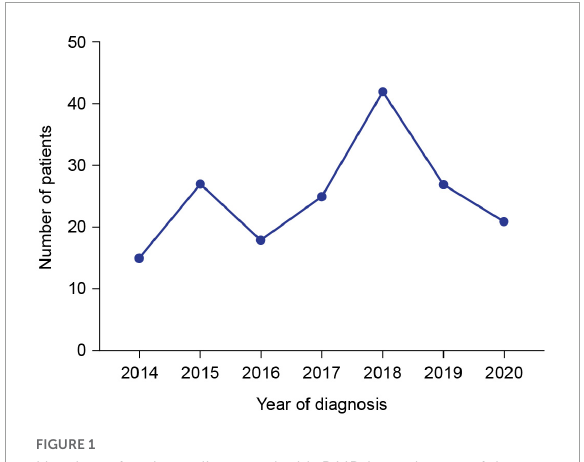
FIGURE1 Number of patients diagnosed with DMD in each year of the study. Data for 2021 are not included because the data cut-off was on April 20, 2021.